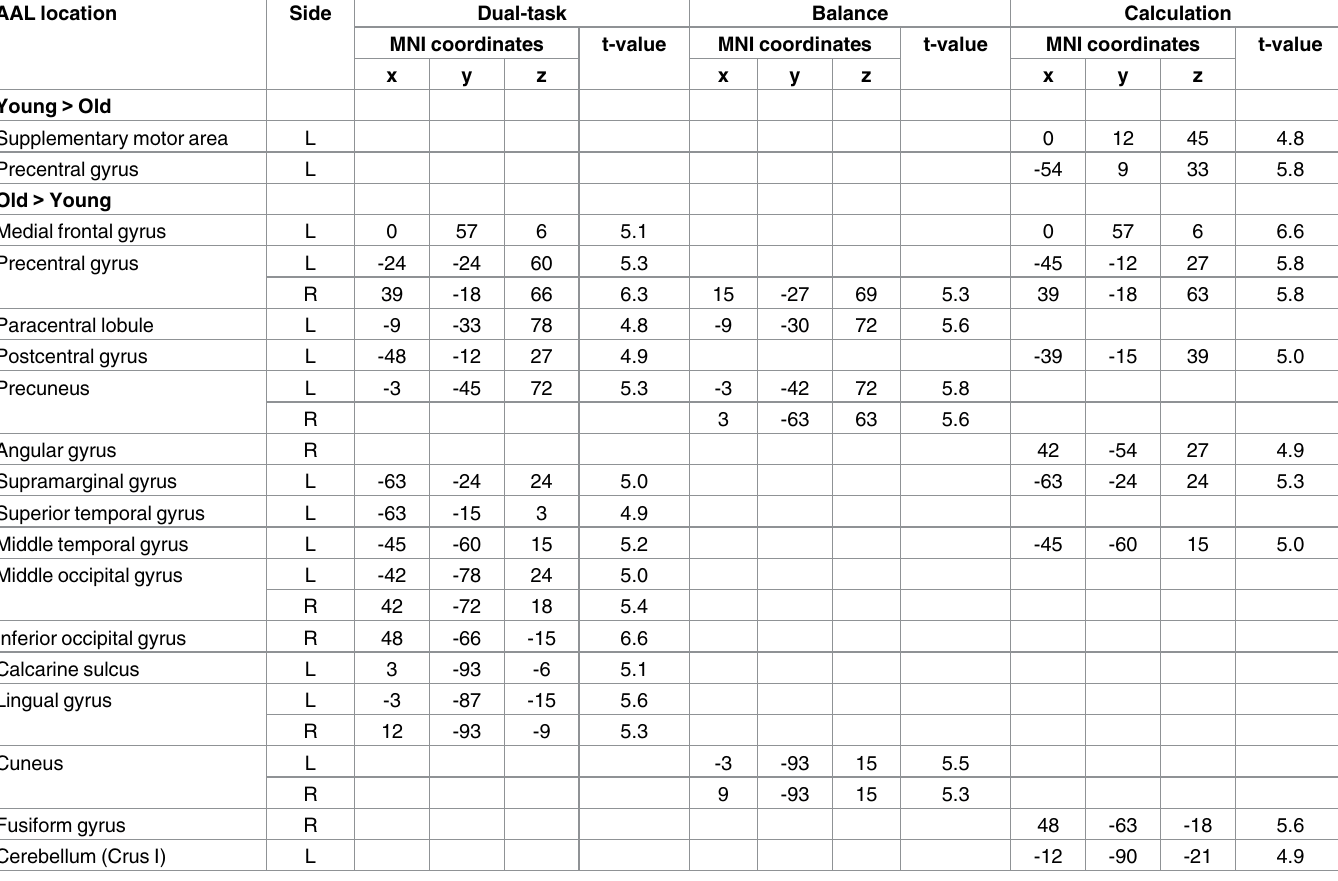
Table 3. MNI coordinates and t-values of the local maximawith significant age-related differences in activation during balance, calculation and dual-tasking (p < 0.05; FWE corrected for multiple comparisons). Voxel size is 3x3x3